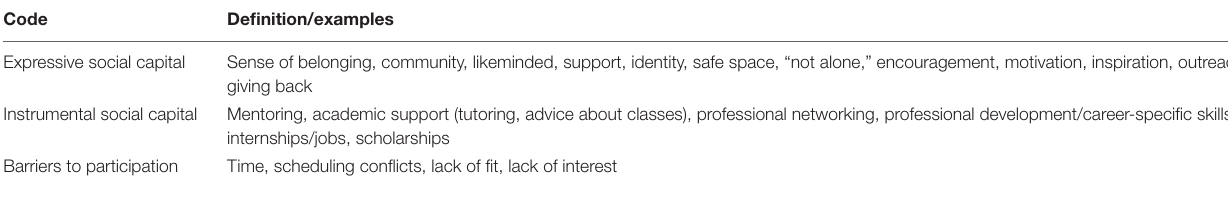
TABLE 1 | Codebook used for analyzing qualitative